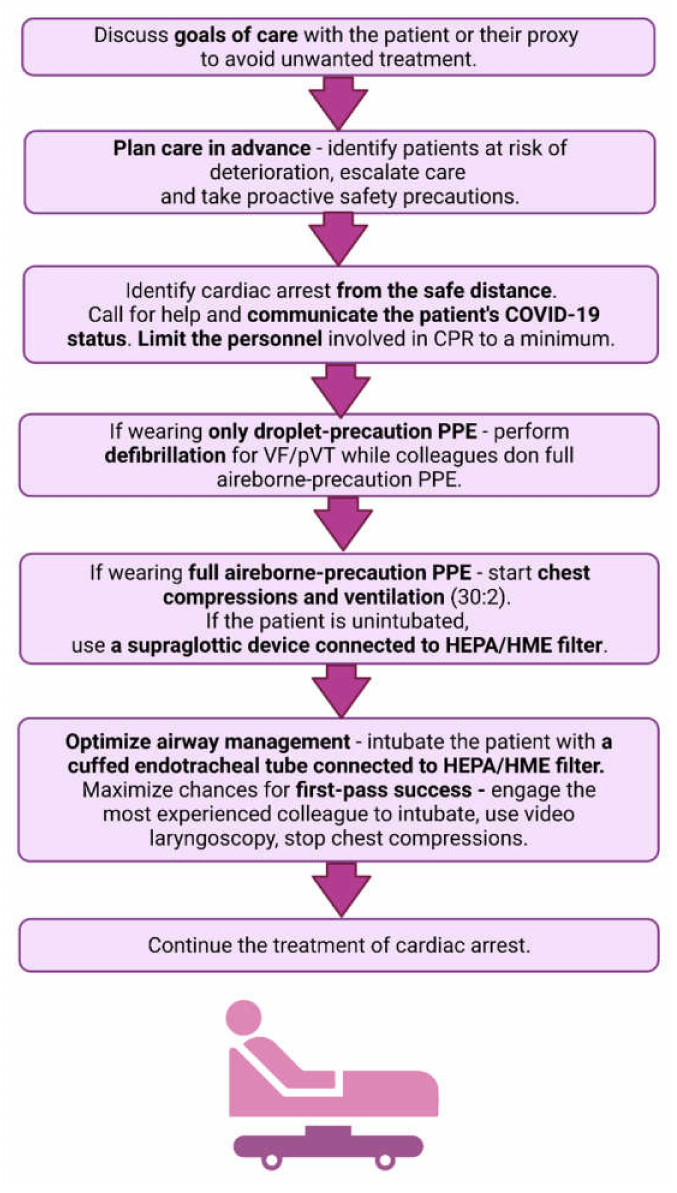
Figure 3. A summary of novel Advanced Life Support recommendations. The modified recommen- dations are marked in